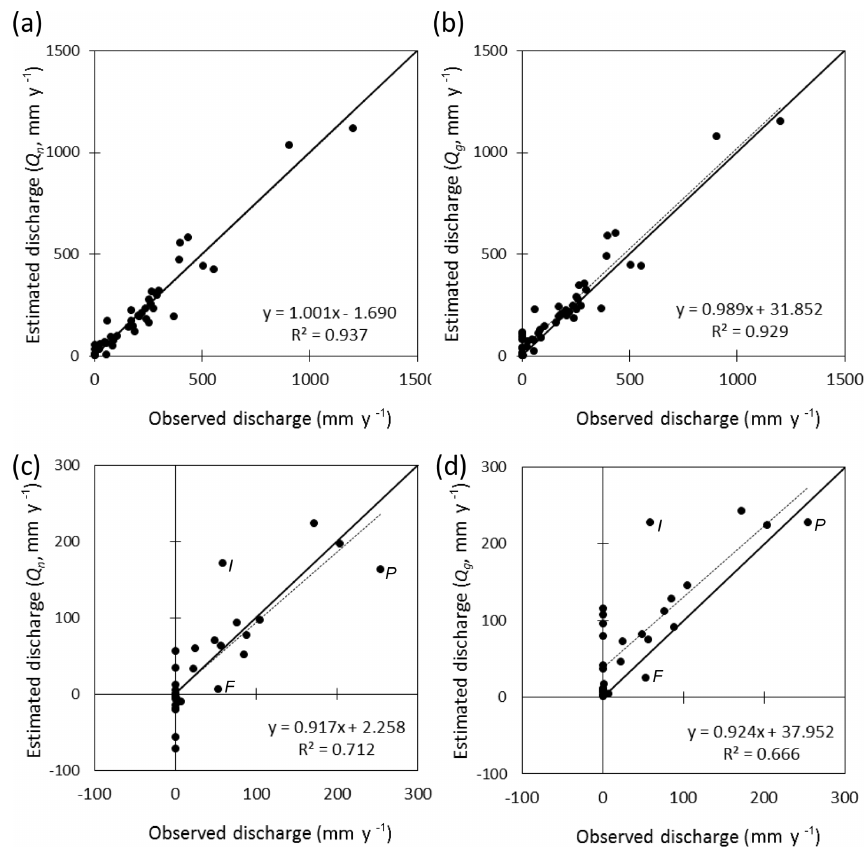
Figure 5. Comparison of observed basin-average discharge (mmyr − 1 ) for large basins that are internally draining (i.e., zero discharge) or have adequate station discharge data, respectively, with model estimates of (a) net discharge ( Q n ) , that is, gross discharge ( Q g ) minus secondary evaporation and (b) Q g only. Panels (c) and (d) represent data for discharge below 300mmyr − 1 only (cf. Table 1). Letters indicate the Indus (I), Paraná (P) and Fitzroy (F) River.